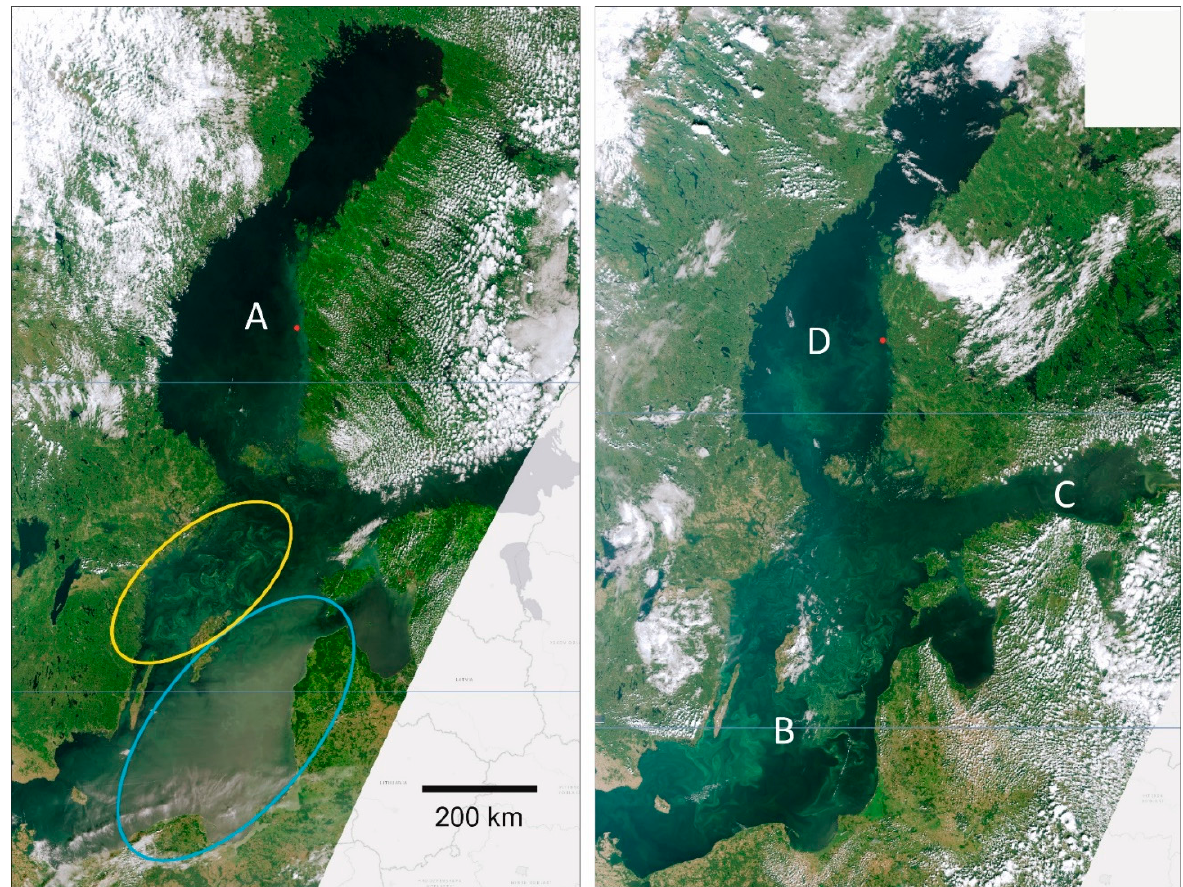
Figure 5. MERIS RGB composition on 24 July 2008 ( left ) and 31 July 2008 ( right ). On the left, inside the blue ellipse, the cyanobacteria is mixed in the water column and inside the yellow ellipse it is accumulated on the surface in calm conditions. There are no cyanobacterial blooms in the northern basins ( A ). A week later new blooms have emerged ( C , D ) and under calm conditions the blooms form clear spatial patterns on the surface ( B ). The red dot on the Bothnian Sea coast refers to the R z (620) time series in Figure 5. Figures contain modified Copernicus data, SYKE (2020).